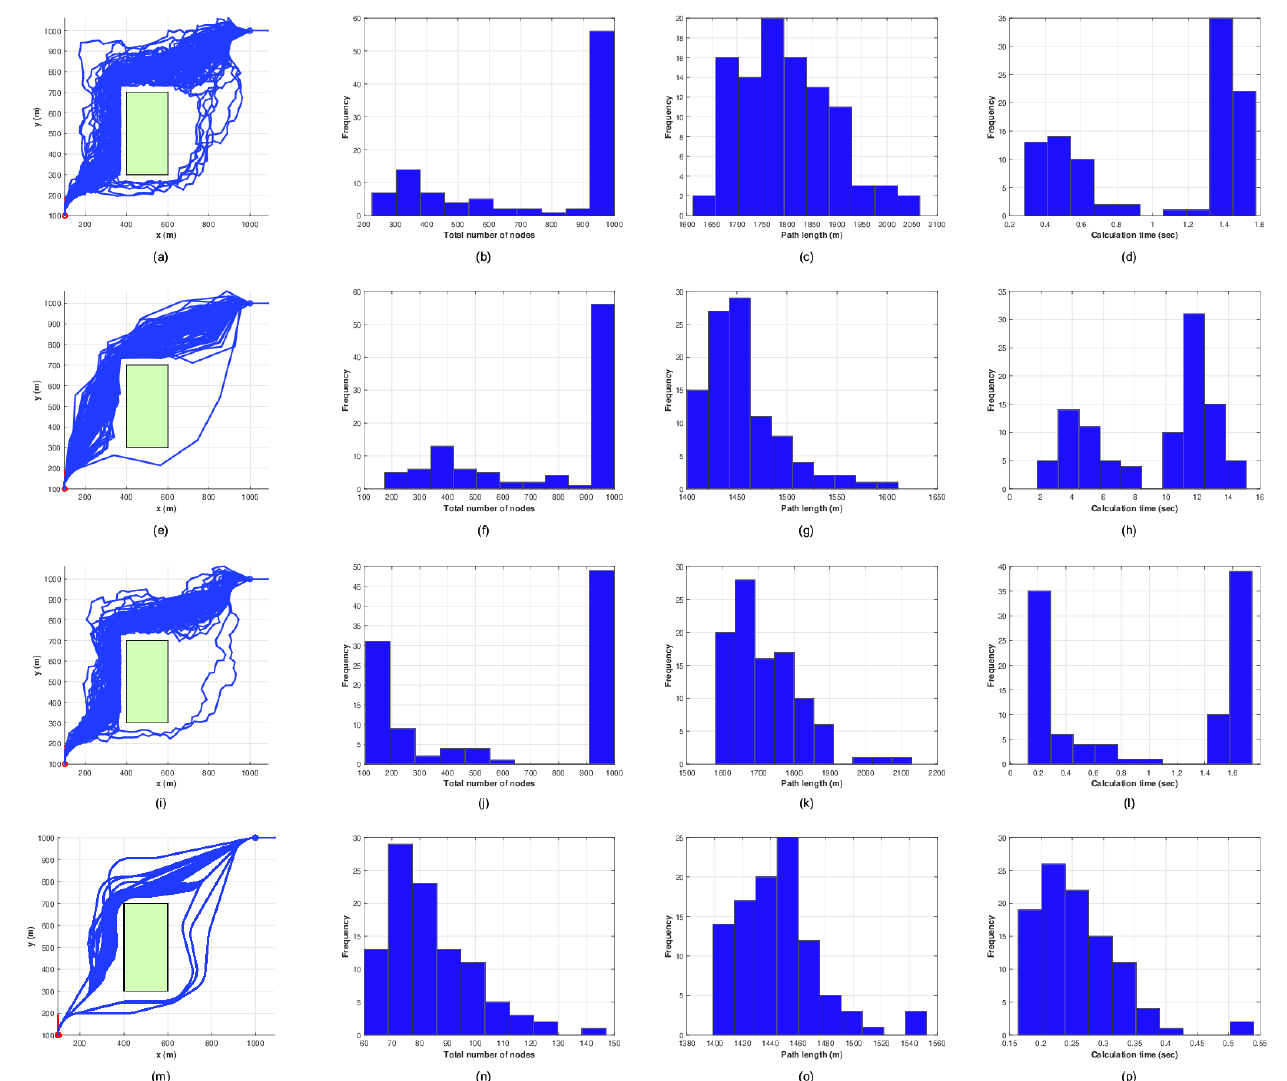
Figure 10. Results of center obstacle: ( a – d ) RRT. ( e – h ) RRT*. ( i – l ) Biased RRT. ( m – p ) Dubins